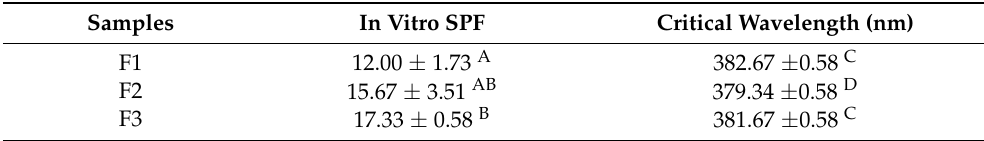
Table 2. In vitro sun protection factor (SPF) values and critical wavelength (nm) of sunscreens (F1, F2, and F3). Samples In Vitro SPF Critical Wavelength (nm)